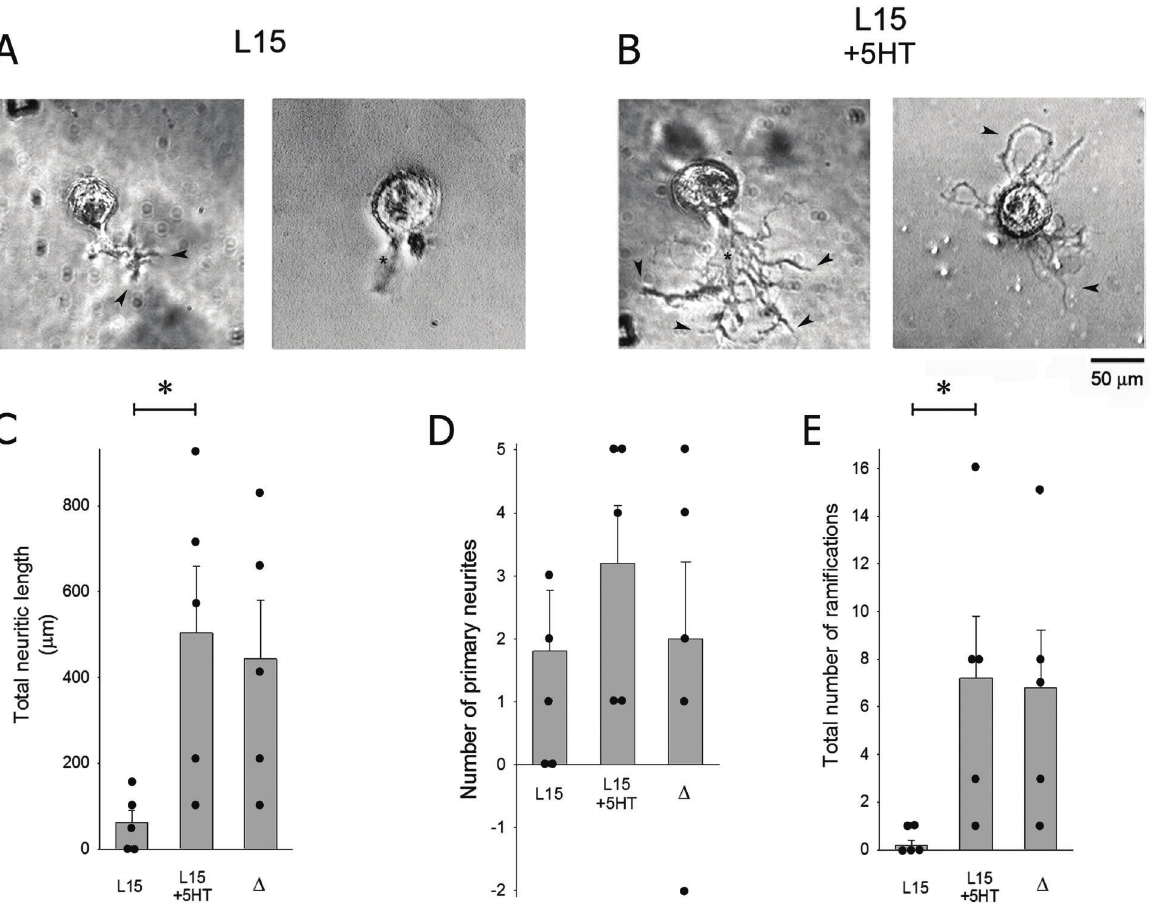
Figure 5. Effect of serotonin (5HT) on the morphologic pattern of AL1 neurons. A , Upon removal and culture on glass plates, they yield short primary neurites with few rami fi cations. The arrowheads show several neurites and the asterisks show some lamellipodia. B , The presence of serotonin induced extensive neurite growth and increased its rami fi cations but had no effect on the number of primary neurites. C – E , The neurotransmitter increased the total neuritic length 8.3-fold and the rami fi cations18-fold, but had a smaller (non- statistically signi fi cant) effect on the number of primary neurites. D denotes the average difference ( ‘ with 5HT ’ minus ‘ without 5HT ’ ) for each pair of neurons from the same experiment. Asterisks denote 95% statistical signi fi cance with the unpaired t -test. Data are reported as means ±